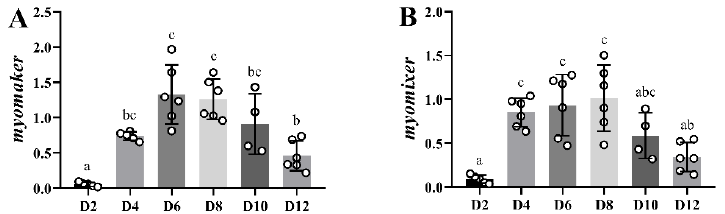
Figure 8. Bar plots of relative gene expression of myomaker ( A ) and myomixer ( B ) along the primary culture of myoblasts. White-filled circles represent individual relative gene expression values. Data are presented as means ± SEM ( n = 6). Different letters indicate significant differences ( p < 0.05).